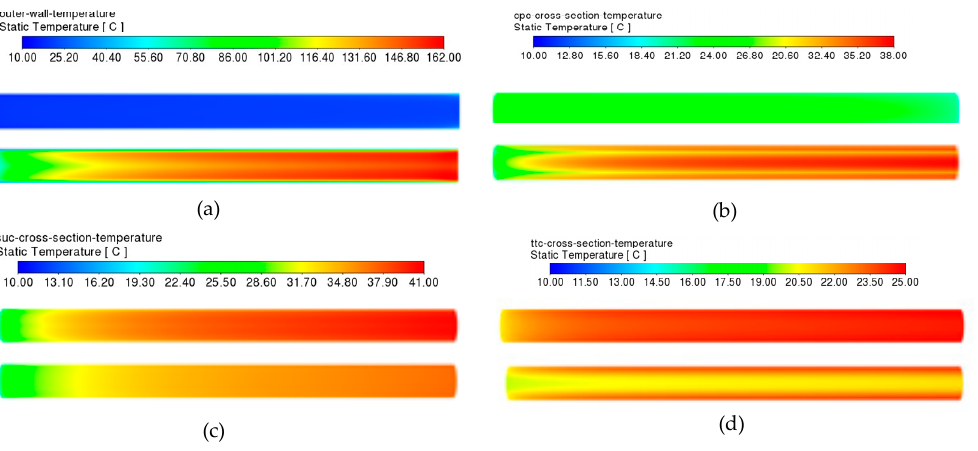
Figure 12. The top wall and bottom wall temperatures of ( a ) the PTC, ( b ) the CPC, ( c ) the SUC and ( d ) the TTC in the SWH systems, where the above figure and below figure refer to the top wall and bottom wall respectively, and the left side and right side are the water inlet and outlet respectively.